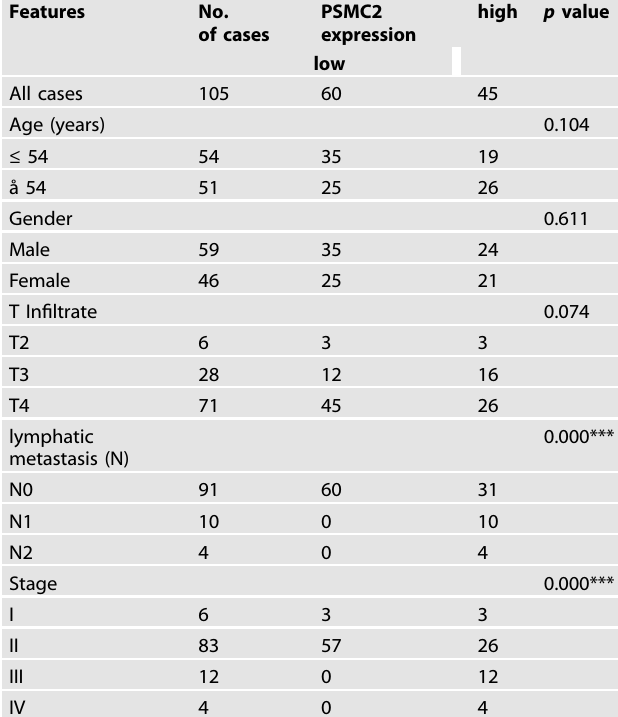
Table 1. Relationship between PSMC2 expression and clinical characteristics in patients with skin cutaneous